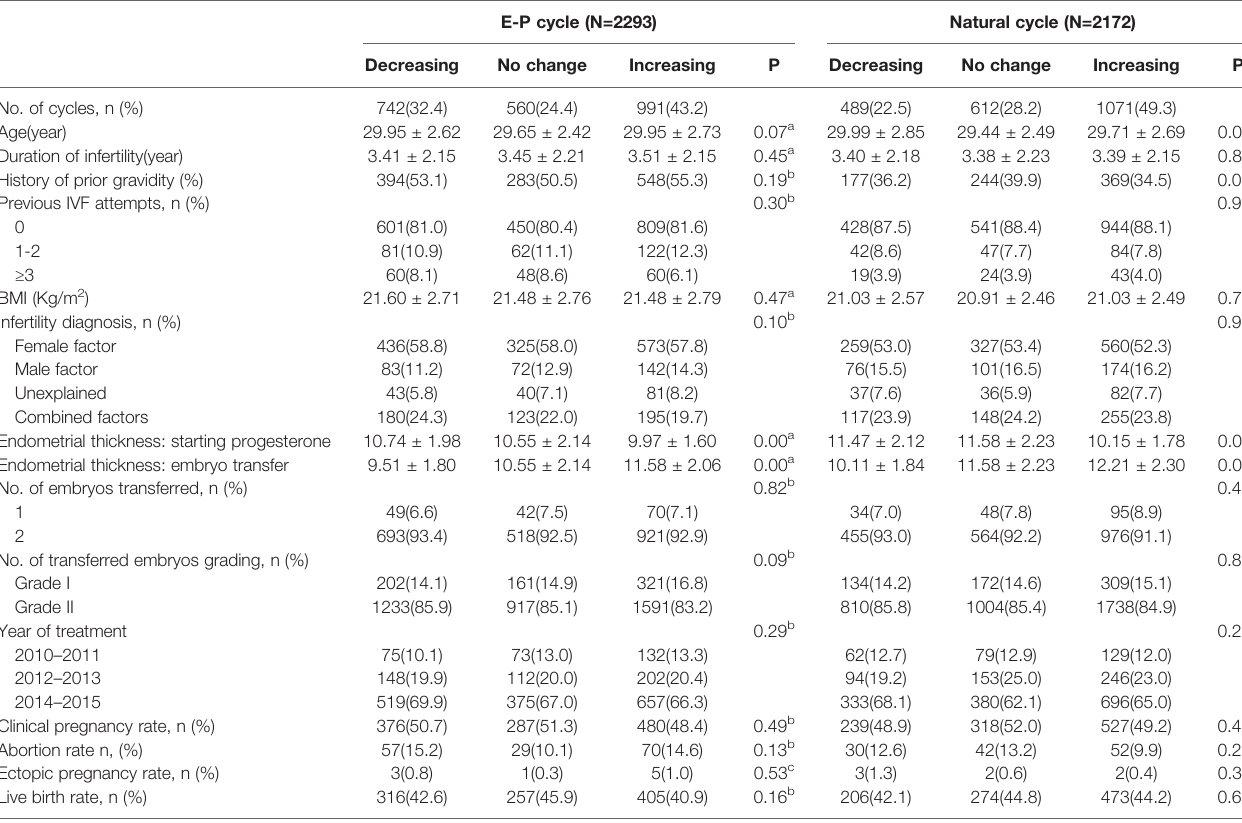
TABLE 2 | Basic characteristics and pregnancy outcomes in women treated with different endometrial preparation protocols during FET cycles. E-P cycle (N=2293) Natural cycle (N=2172) No